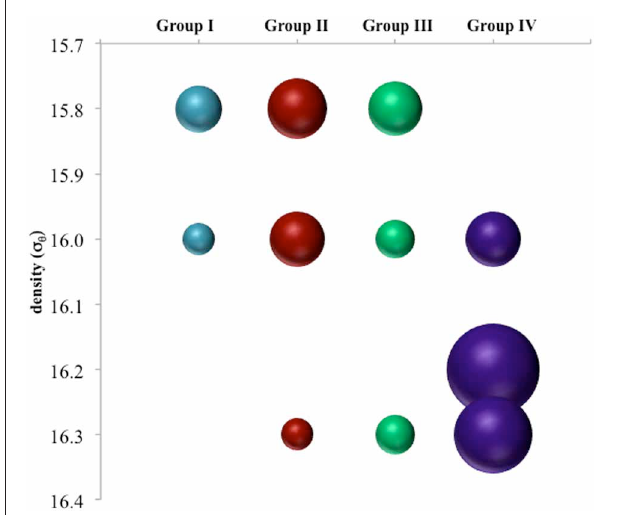
FIGURE 4 | Depth breakdown of groups noted in Figure 3. Area of bubbles are proportional to percentage of clone library sequences for a given depth found in a given group.